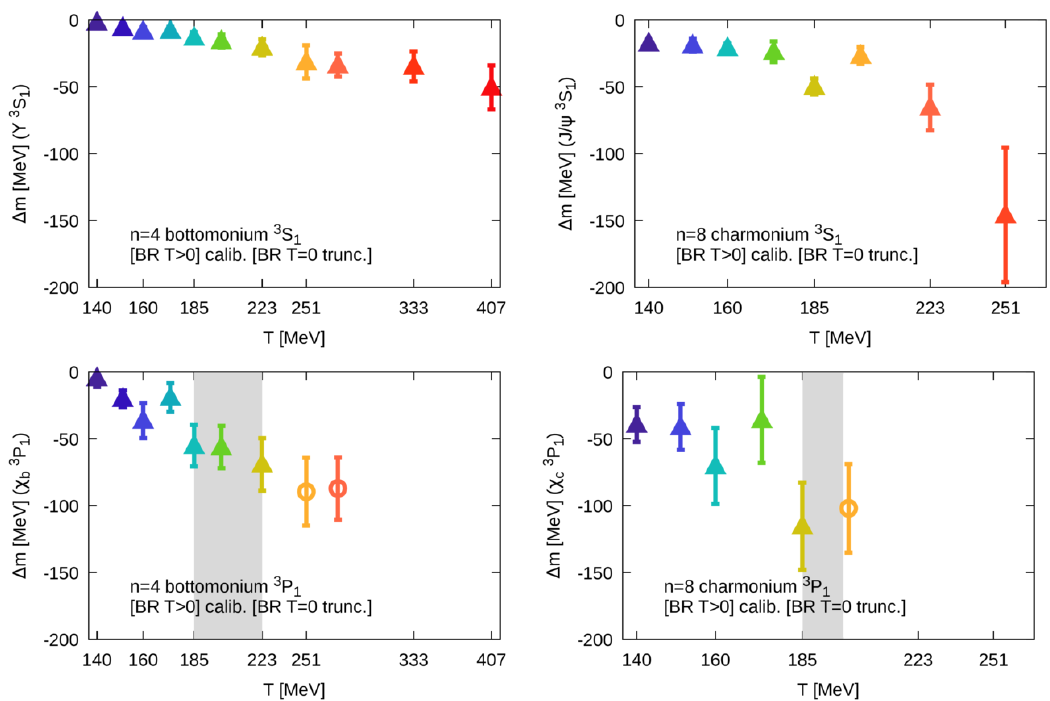
Figure 24 . In medium mass shifts for bottomonium (left) and charmonium (right). The S-wave channel is depicted in the top row, the P-wave channel in the bottom row. The area right of the gray separator refers to the temperature range in which the smooth BR method indicates that the standard BR method may not provide a robust determination of the ground state